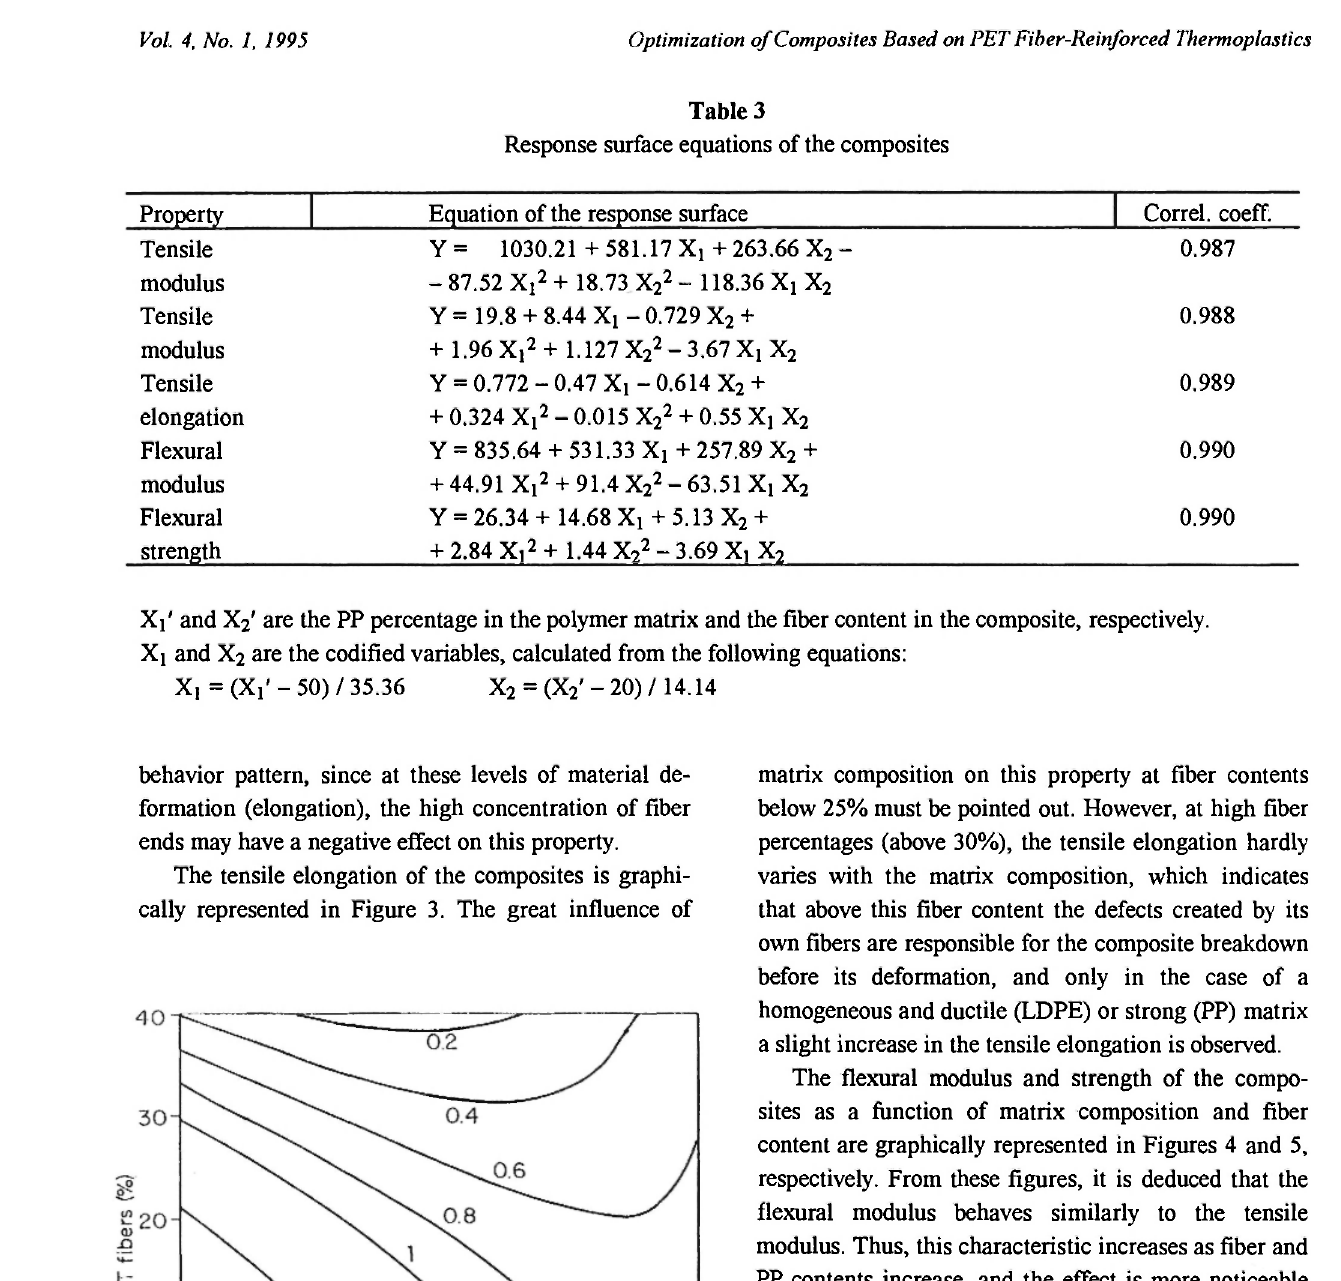
Fig. 3: Tensile elongation of PET fiber-filled composites based on LDPE/PP blends as a function of matrix composition and fiber